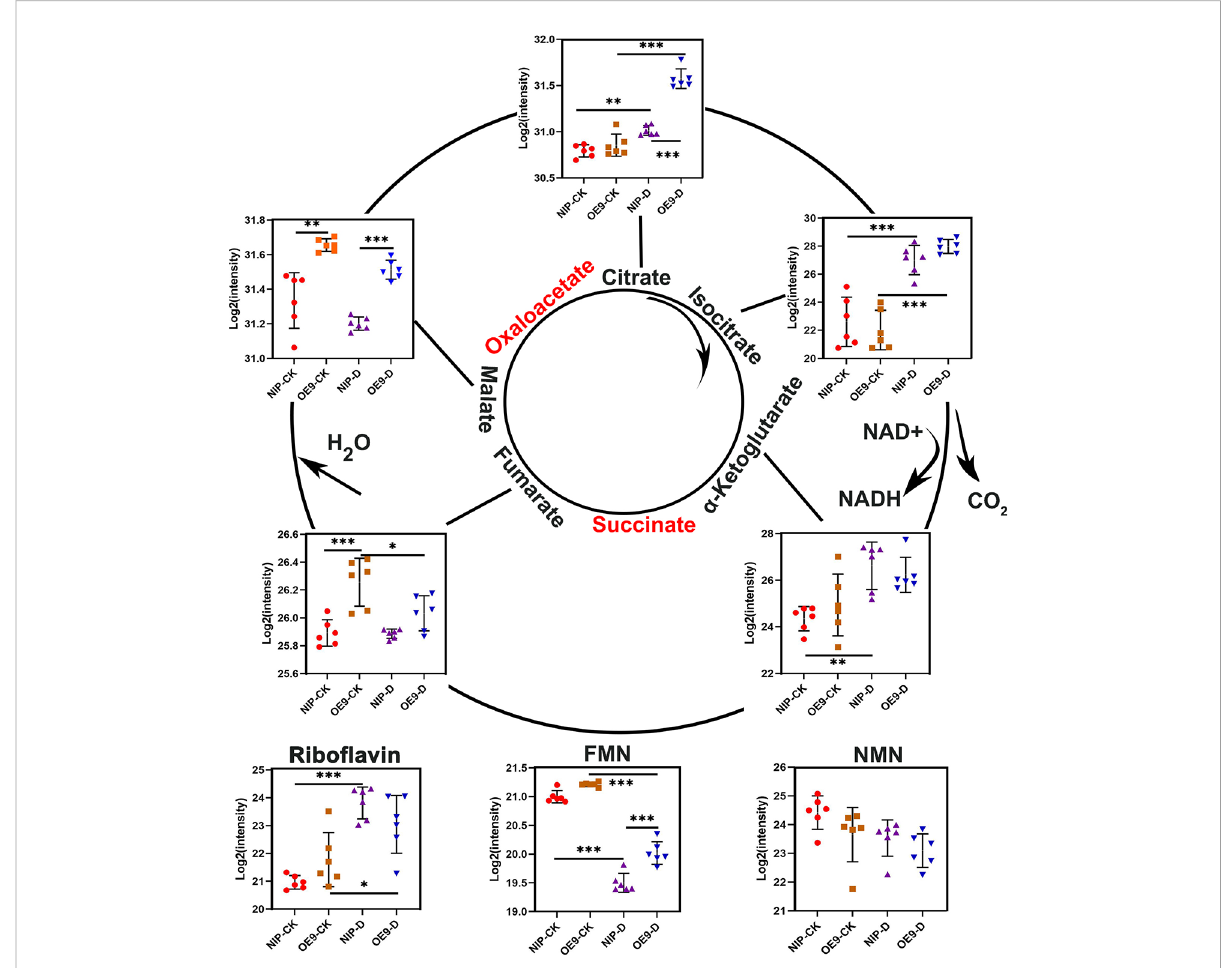
FIGURE 6 Changes in the contents of intermediate metabolites in the TCA cycle in rice roots under drought. Asterisks indicate signi fi cance (*p < 0.05, **p < 0.01, ***p <